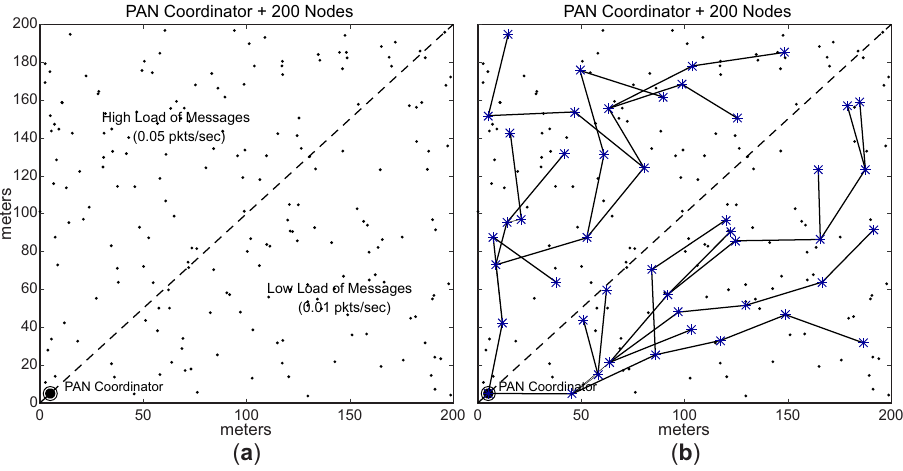
Figure 13. Configuration of the conditioned Scenario : ( a ) Data rates distributed in two load zones; ( b ) Conditioned cluster-tree